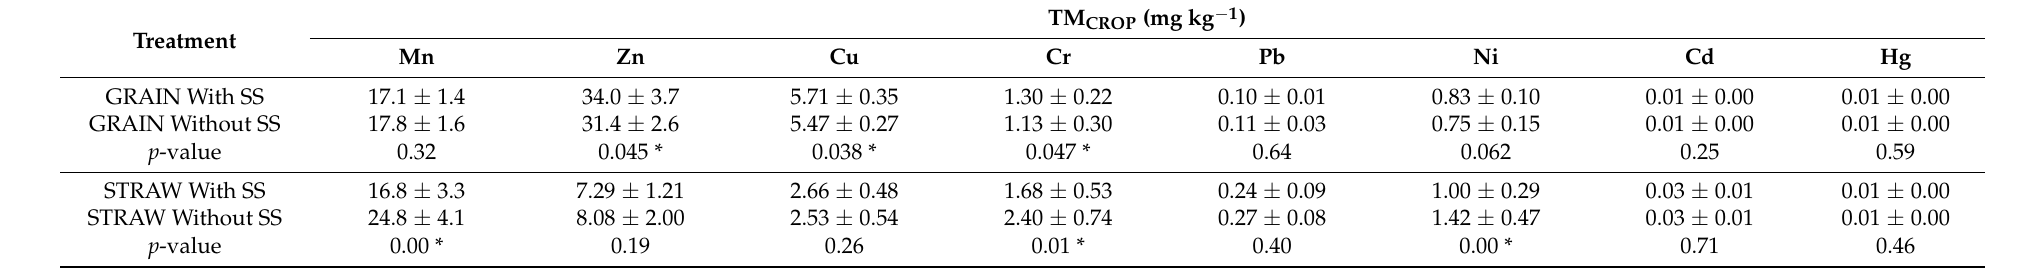
Table 7. Mean ± standard deviation of the concentration of Mn, Zn, Cu, Cr, Pb, Ni, Cd and Hg in the crop (grain and straw), depending on whether or not they have received SS, together with their p